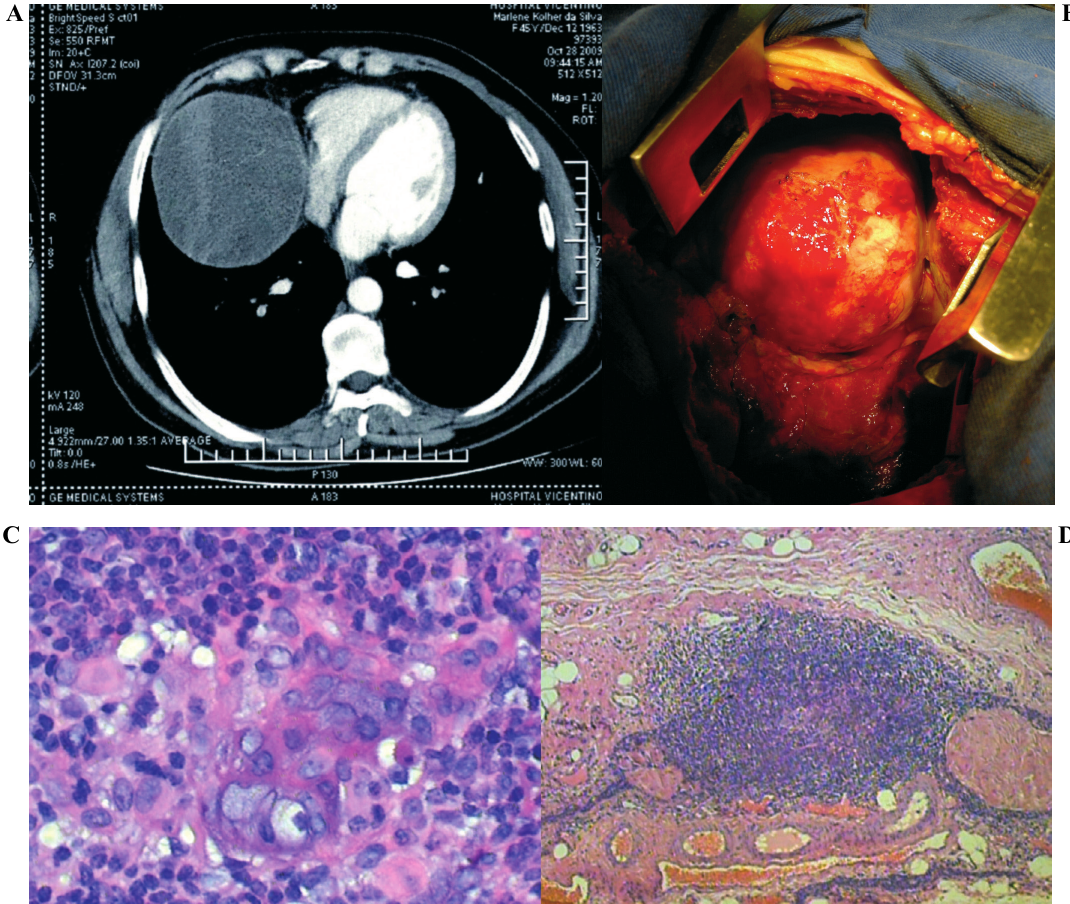
Fig. 1 - A: Computed tomography indicating well-defined mass with regular margins, in close contact with the heart and the right anterolateral chest wall. B: Right thoracotomy showing giant mass adhered to the right pericardial surface and the right lung. C: Hassall’s corpuscle (multiple layers of epithelial reticular cells arranged concentrically, in the shape of an “onion”). In general, reticular cells are in the center of the Hassall’s corpuscle, lined by a layer of medullary epithelial cells. D: Hassall’s corpuscle in the lesion (smaller